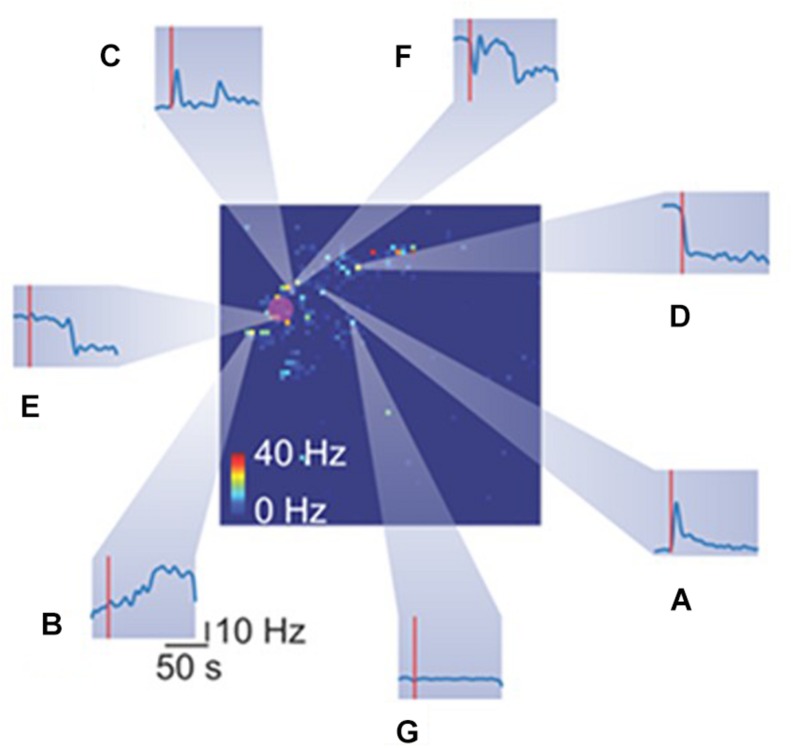
Heterogeneous spiking activity response of retinal ganglion cells (RGCs) to mechanical stimulation. The big square represents the retina spiking activity collected from the HD-MEAs. Each pixel color code the mean firing rate of the RGC recorded from a specific electrode. The red rounded shaded area highlight the indentation area. Each inset (from A–G) reports the temporal spiking dynamics of different RGCs in response to the same mechanical stimulation (red vertical line represents the stimulation time).